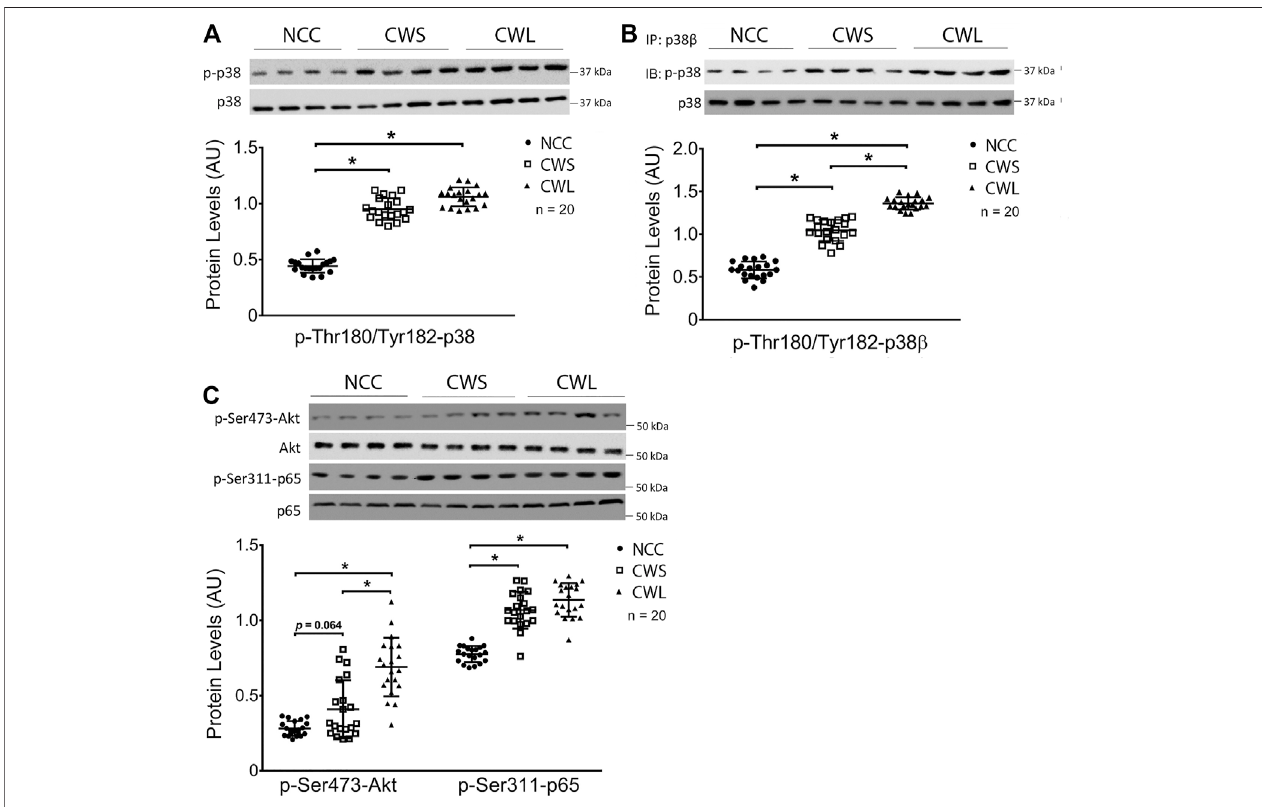
FIGURE1| Activepan-p38 MAPK, p38 β MAPK,AKT andNF- κ Barehigher inRAofcancerpatients. (A) Active pan-p38 MAPKwasanalyzed byWesternblotting. (B) Active p38 β MAPK was analyzed by immunoprecipitation. (C) Active AKT and NF- κ B were analyzed by Western blotting. Data were analyzed by one-way ANOVA combined with Tukey ’ s test. * denotes p <